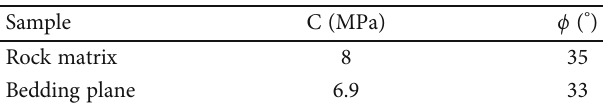
Table 5: Strength parameters of the middle-deep transition shale